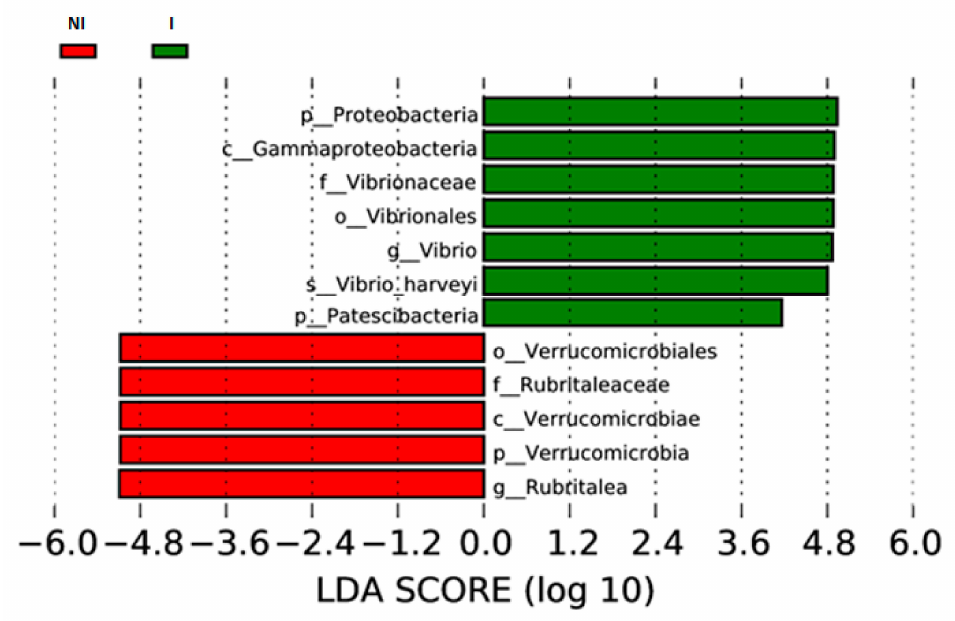
Figure 11. Linear discriminant analysis (LDA) effect size (LEfSe) analysis of skin mucus microbiota of European sea bass non-infected (NI) and infected (I) with V. harveyi . LDA scores for differentially abundant taxa in the microbiota of infected fish are shown in green and in the microbiota of non-infected fish in red. Prefixes represent abbreviations for taxonomic rank of each taxa, with phylum (p_), class (c_), order (o_), family (f_), genus (g_), and species